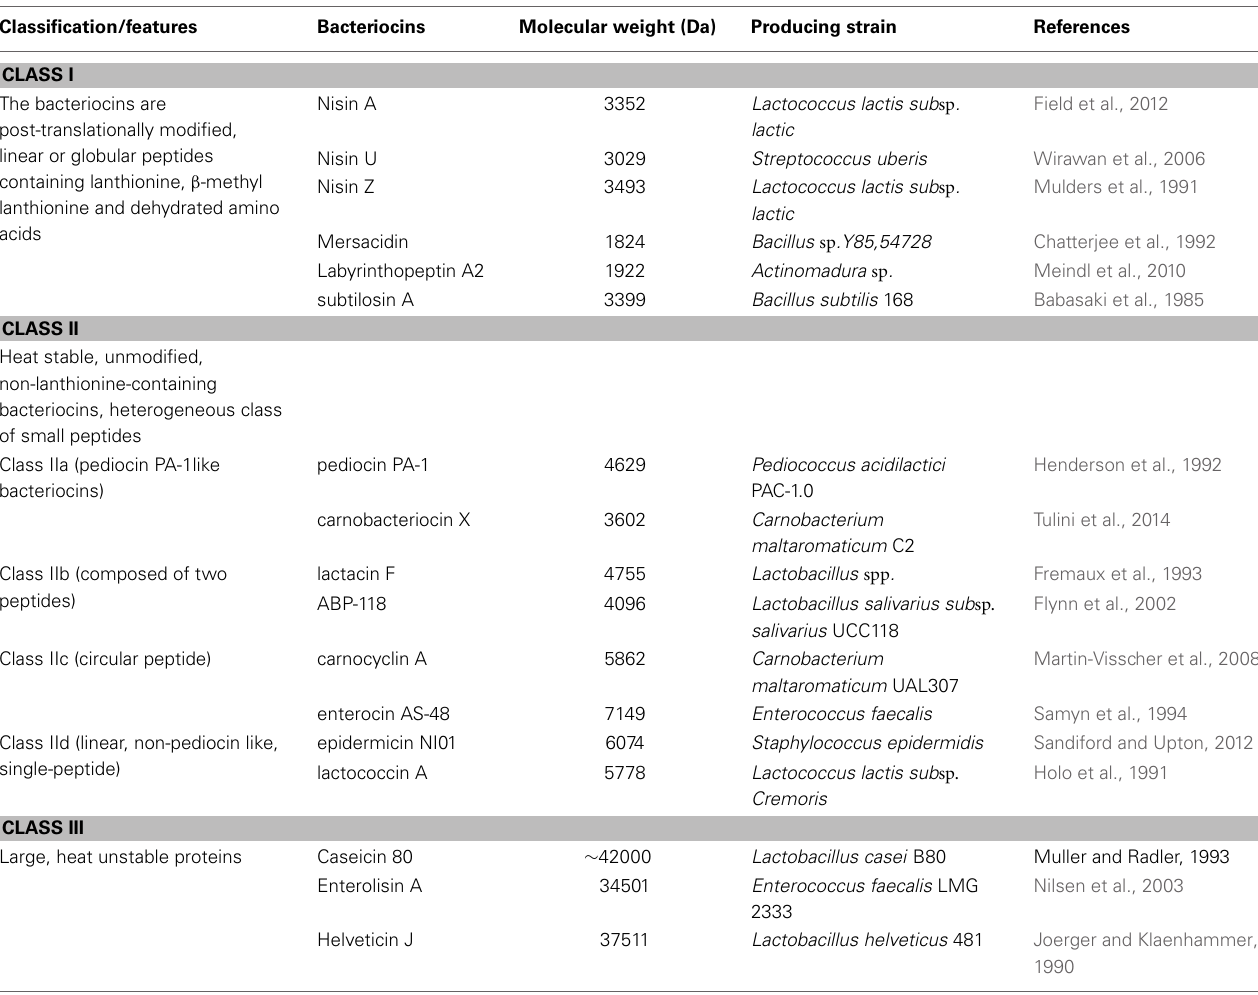
Table 3 | Classification scheme for gram-positive